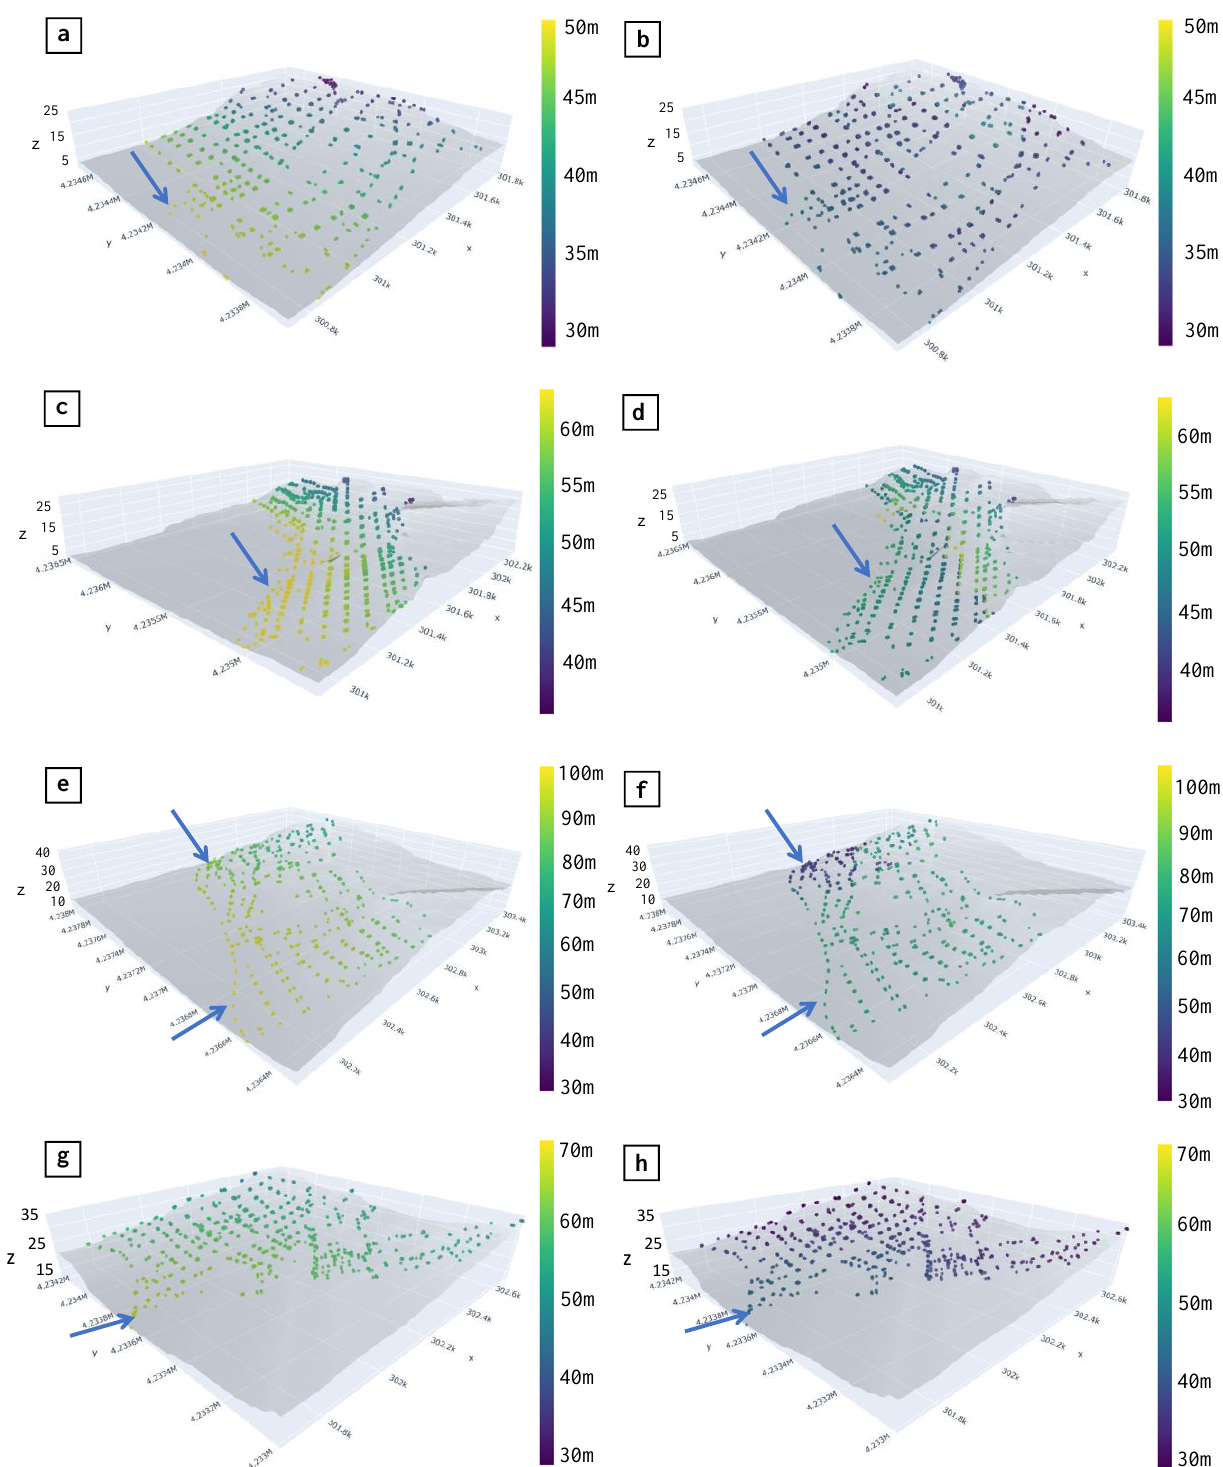
Figure 5. Three-dimensional plots of the location and simulated pressure heads of the original (i.e., one cluster; left column), and final network configurations (right column) of the four PMAs: ( a , b ) Boud; ( c , d ) Kentro; ( e , f ) Panachaiki, and ( g , h ) Prosfygika. Ground surface is shown in grey, while arrows indicate regions with a significant decrease of the pressure heads relative to the original network configuration (left column). PMA locations are illustrated in Figure 1.